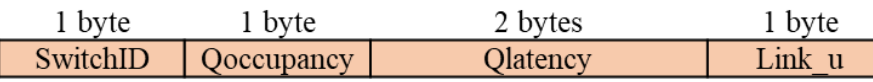
Figure 8. Flow_h fields.